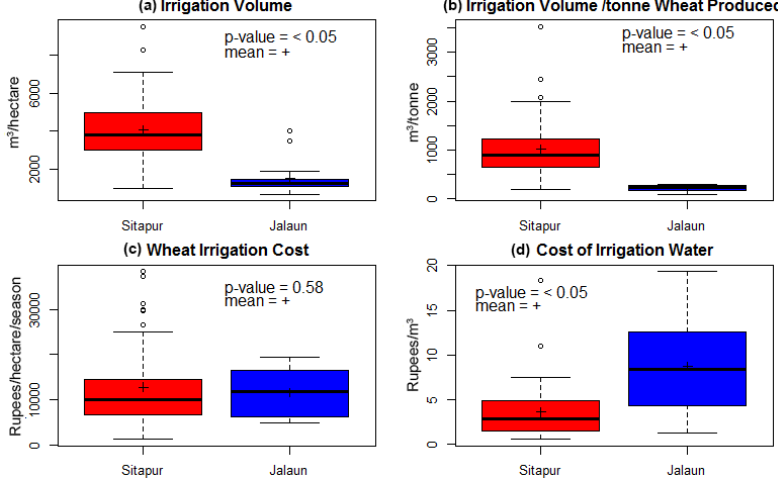
Figure 5. Differences in irrigation practices between tube well only users in the districts of Sitapur and Jalaun, northern India. The boxplots represent variability between farmers in each district. The boxes represent the 25 to 75 percentiles; the whiskers represent 1.5 times the interquartile range (IQR). The P values give the chance of equal mean obtained from Student’s t test.